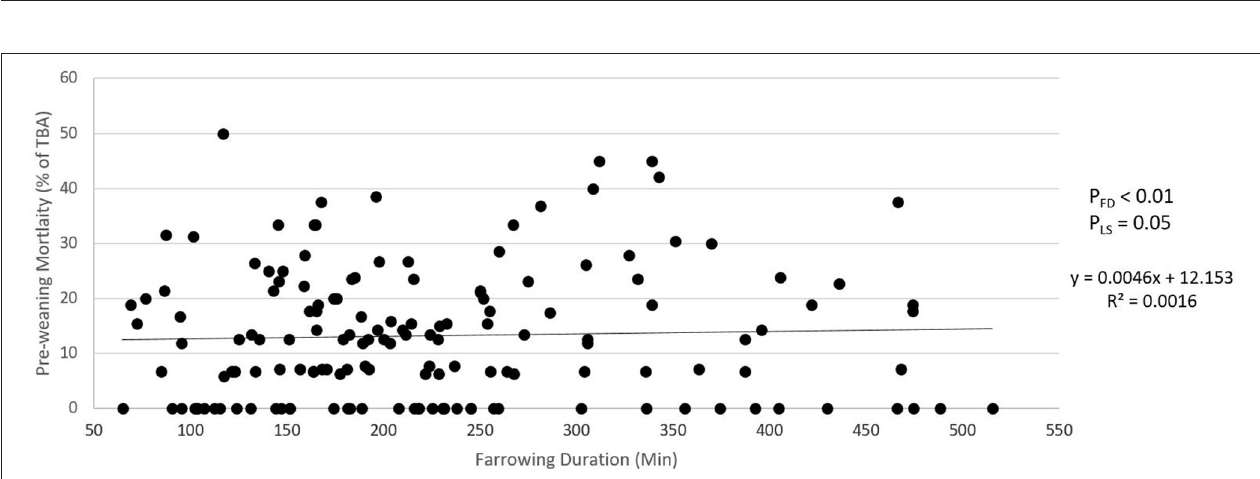
FIGURE 5 | Relationship between farrowing duration and incidence of stillbirth (total still born as percentage of total born). p FD is the p -value for the effect of farrowing duration. p LS is the p -value for the fixed effect of litter size.